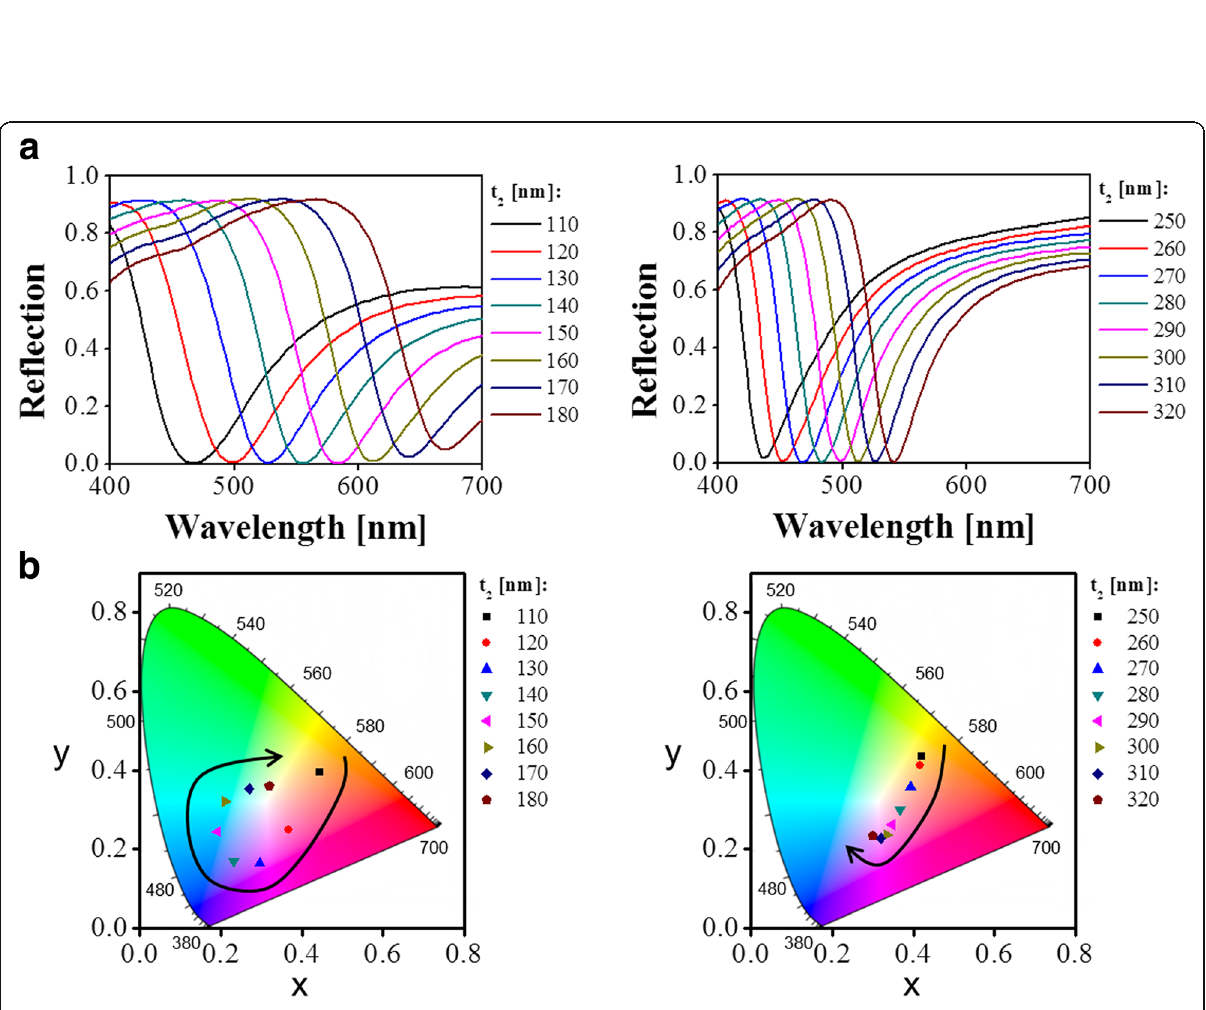
Fig. 2 a Simulated reflection spectral responses of the proposed color filtering structure with NAA thickness varying from 110 to 320 nm. b Corresponding chromaticity coordinates in the CIE 1931 chromaticity